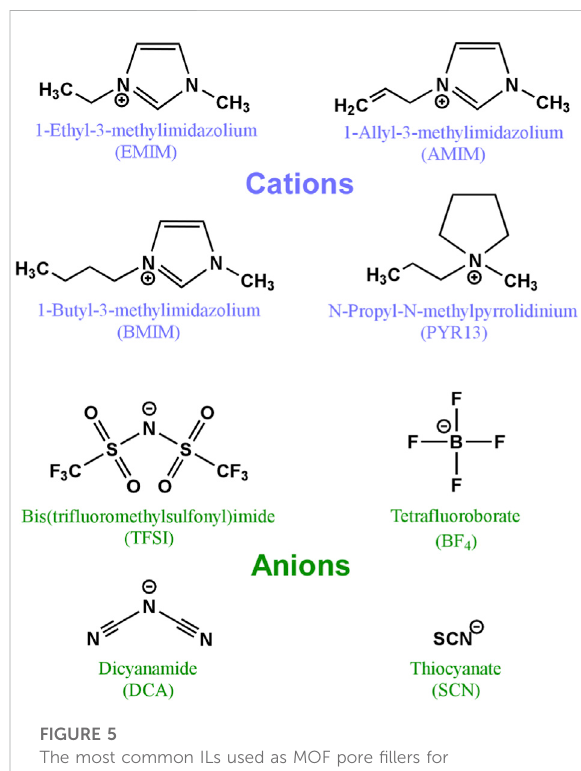
FIGURE 5 The most common ILs used as MOF pore fi llers for electrolytes in sodium and lithium based